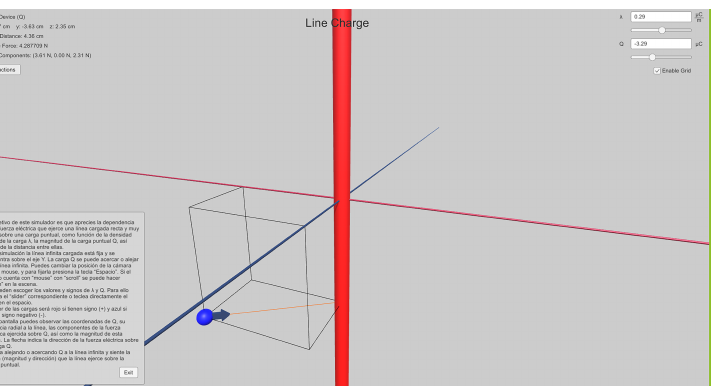
Figure 10. Interface elements of the line charge visuo-haptic environment developed with VIS-HAPT and HaDIU architecture.